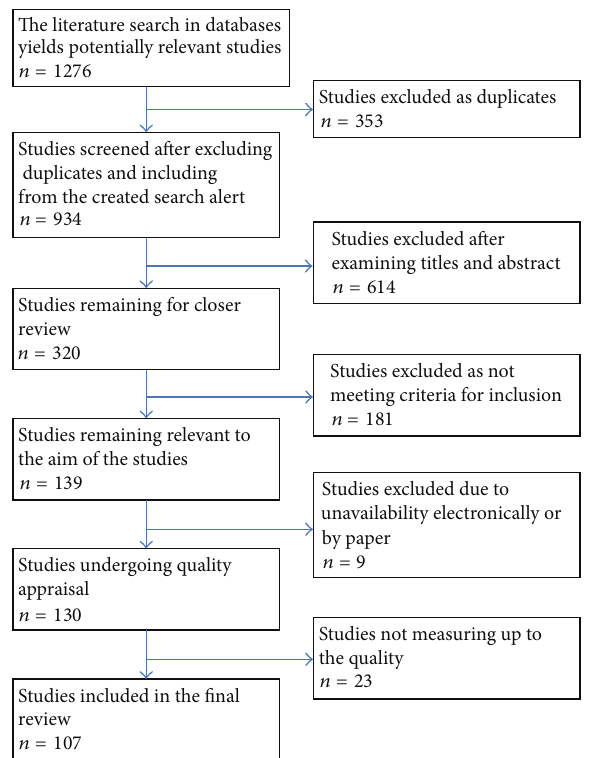
Figure 1: Flow chart of search